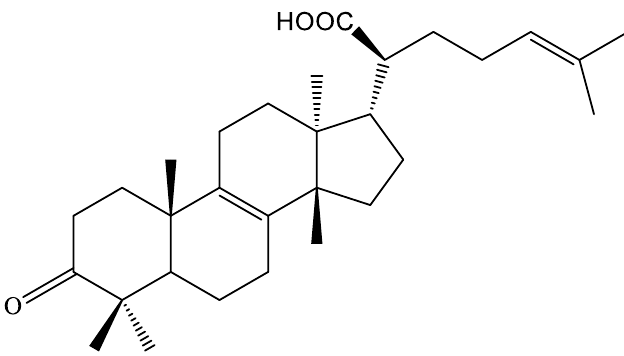
Figure 1. The chemical structur e of the compound (β - elemonic acid, β -EA).